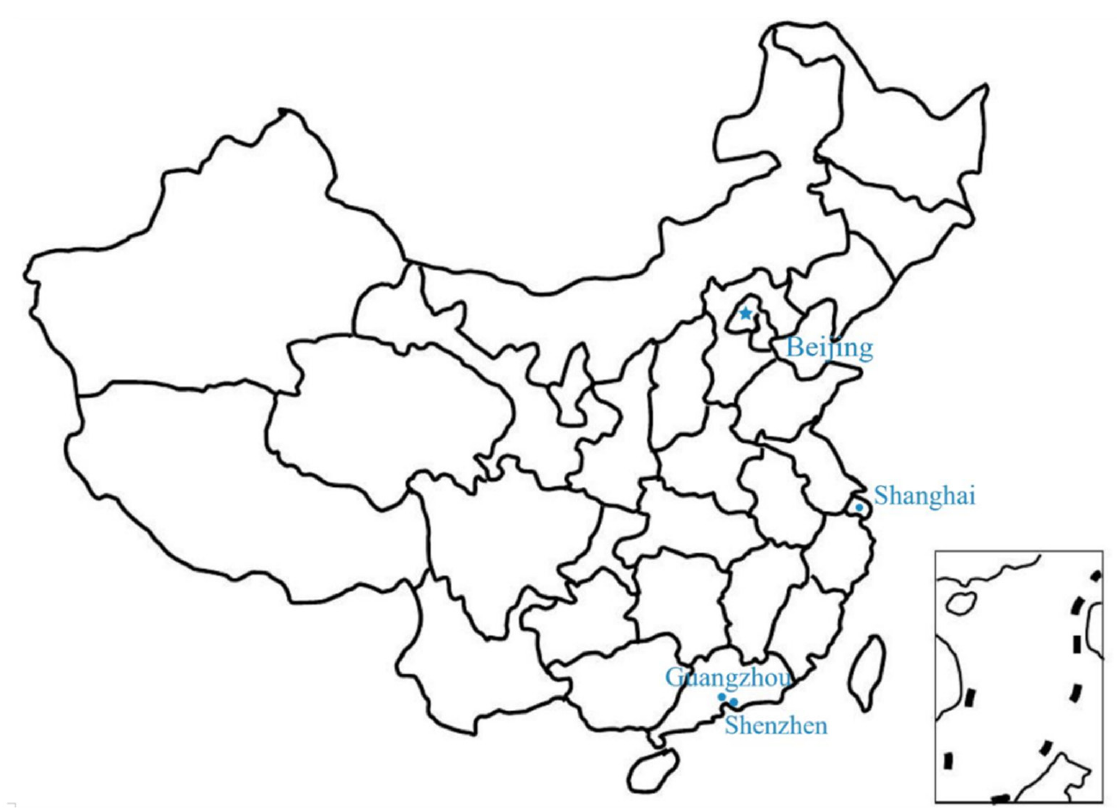
Figure 2. Four megacities in mainland China. Table 1. Descriptive Statistics 1 .